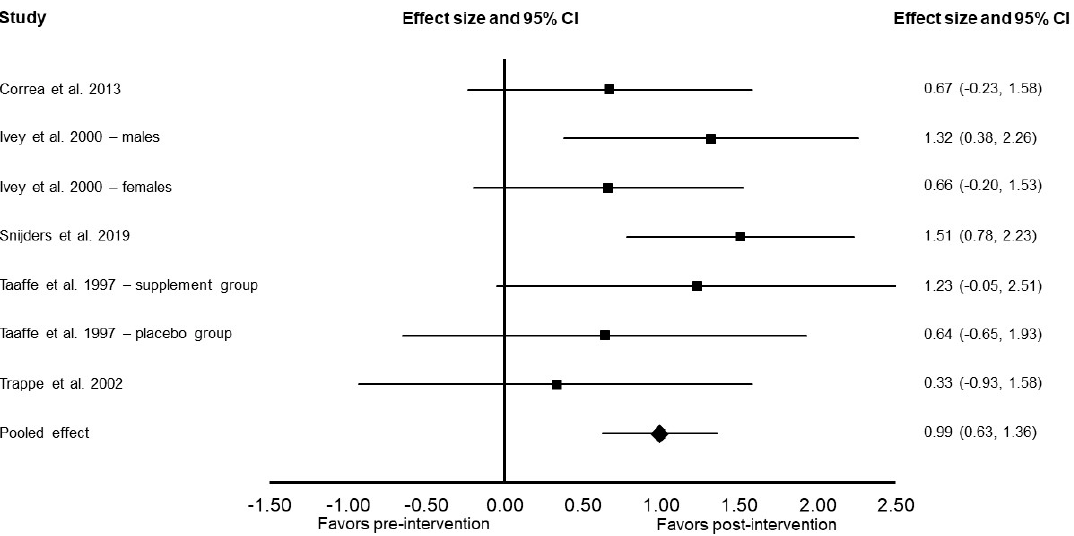
Figure 2. Forest plot presenting the results of the meta-analysis examining the effects of resistance training on muscle size in older adults. Data are reported as Cohen’s d (effect size) and 95% confidence interval (CI). The diamond at the bottom presents the overall effect. The plotted squares denote effect sizes, and the whiskers denote their 95% CIs. The statistical weight of the studies ranged from 7.4% to 19.7% [11–14,16].